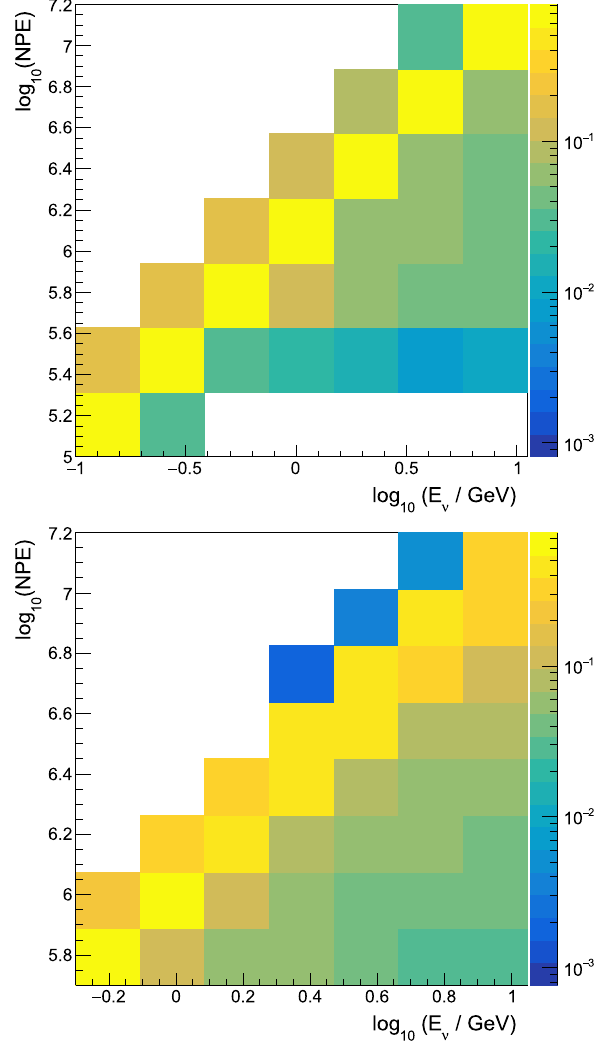
Fig. 6 Likelihood matrix for ν e (top) and ν μ events (bottom)